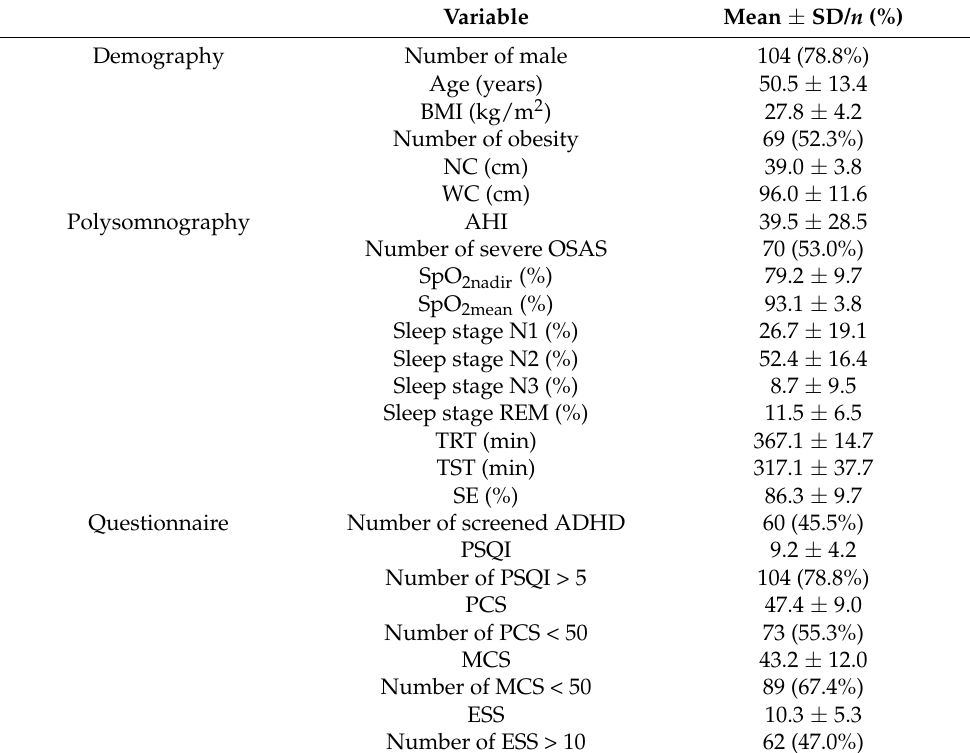
Table 1. The baseline characteristics of the enrolled subjects ( n = 137).